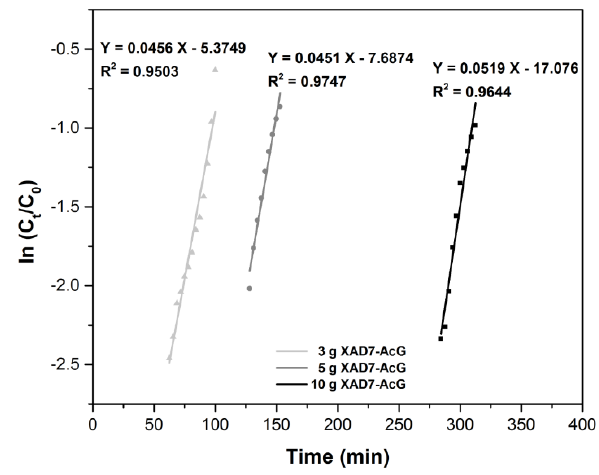
Figure 5. Bohart–Adams plots for the adsorption of Au (III) in the fixed-bed column, at various amounts of adsorbent